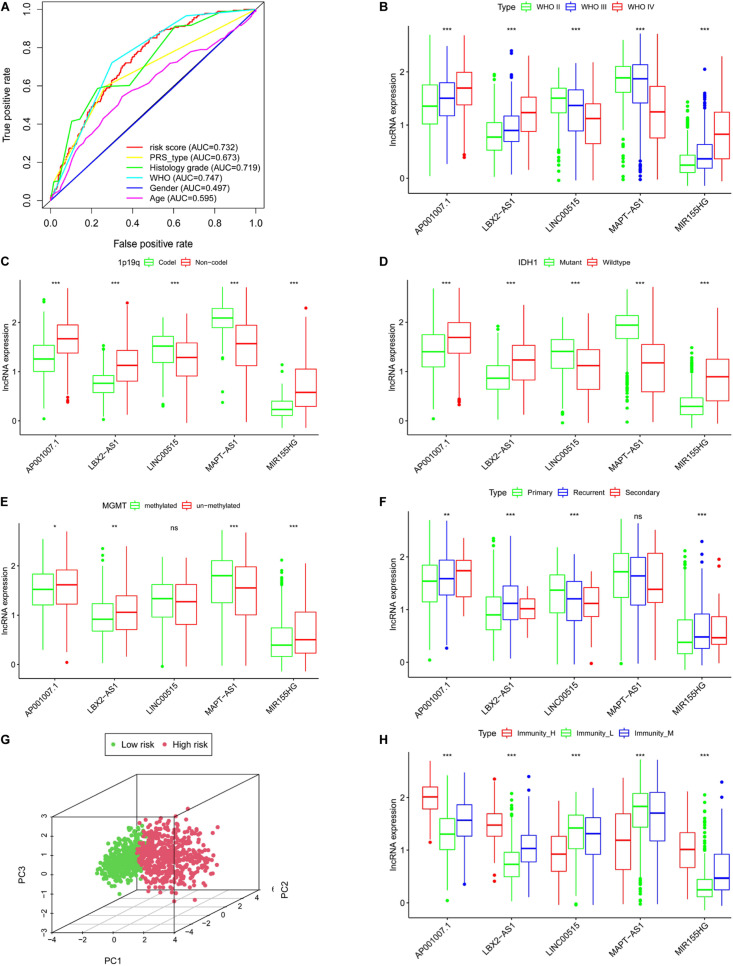
The clinical characteristics of the risk model are based on CGGA. (A) Roc curves of multiple clinical indicators. WHO grade (B), 1p19q status (C), IDH status (D), MGMT methylation status (E), PRS type (F). (G) Principal component analysis of lncRNA related to immune gene set. (H) The expression of lncRNAs in different immune groups, *P < 0.05, **P < 0.01, ***P < 0.001, ns: not statistically significant.